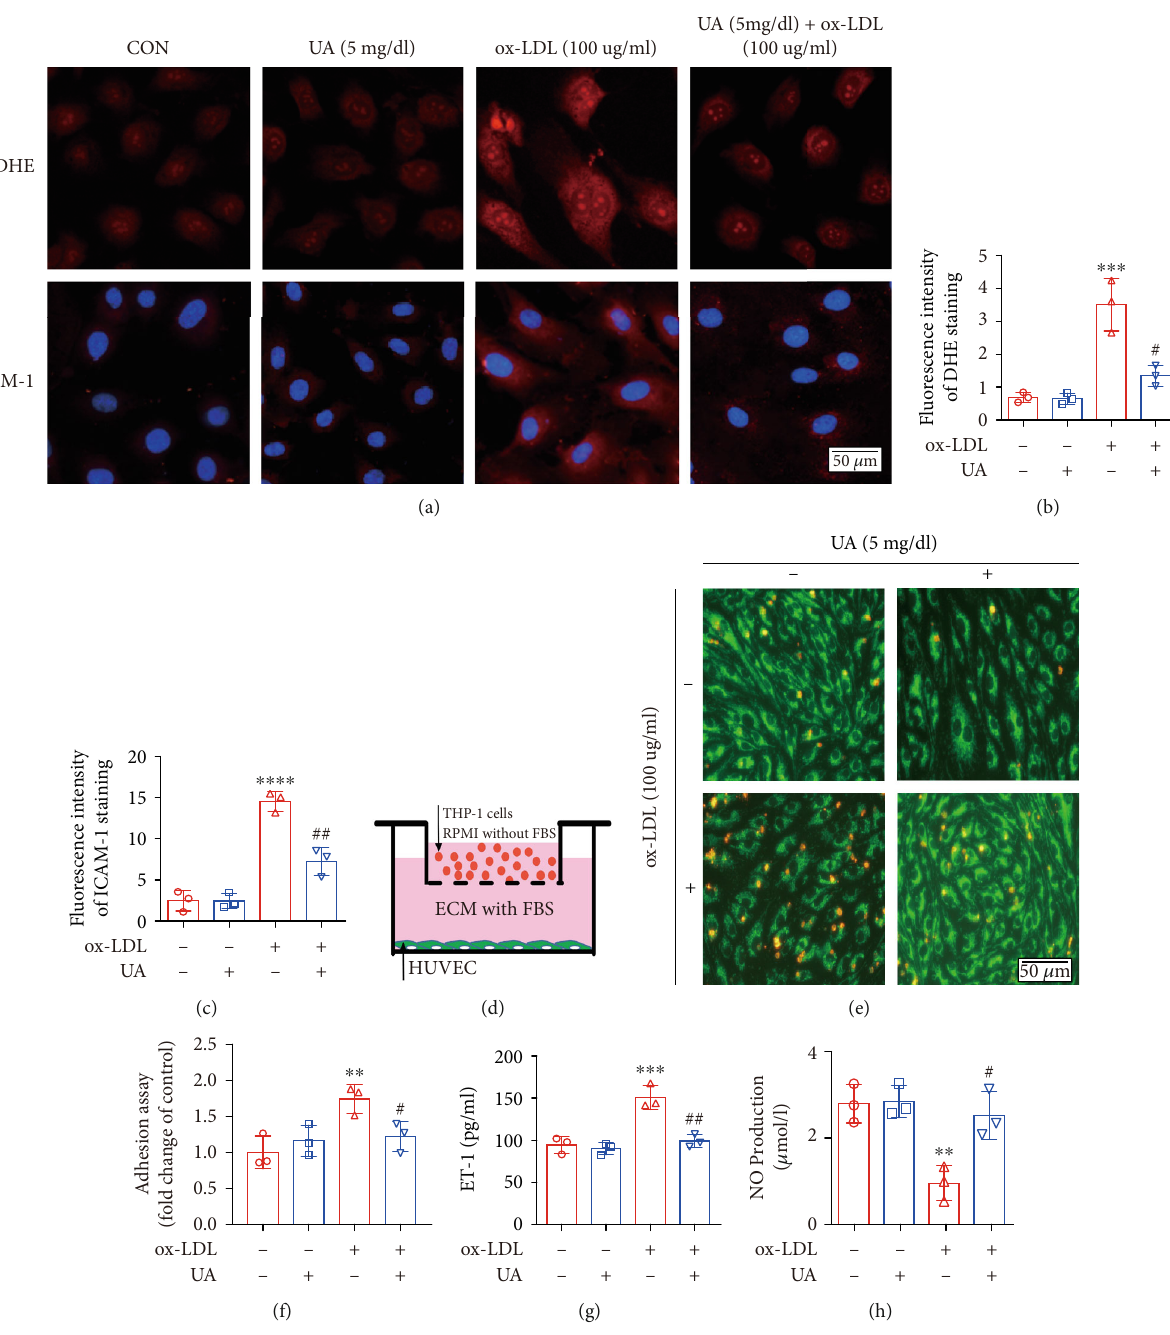
Figure 4: Appropriate concentration uric acid attenuated ox-LDL-induced injured in HUVECs. HUVECs were incubated with ox-LDL (100 μ g/mL) for 24 h, with or without uric acid (5 mg/dL) preincubated for 2 h. Or HUVECs were incubated with uric acid (5 mg/dL) alone for 24 h. (a) Representative immuno fl uorescence image of DHE and ICAM1. Scale bar = 50 μ m. (b) Densitometry analysis of immuno fl uorescent intensity of DHE in the HUVECs in di ff erent groups. (c) Densitometry analysis of immuno fl uorescent intensity of ICAM1 in the HUVECs in di ff erent groups. (d – f) Representative images showed adhesive monocytes to HUVECs under uric acid (5 mg/dL) treatment or ox-LDL (100ug/mL) treatment or uric acid (5 mg/dL)+ ox-LDL (100 μ g/mL). HUVECs were stained by Mito- Green, determined by green fl uorescence, while THP-1 cells were stained by Dil, determined by yellow fl uorescence. Quantitation of adhesive monocytes in di ff erent groups was presented in (f). (g) The e ff ect of uric acid and ox-LDL on ET-1 expression in HUVECs. ET- 1 released into the supernatant was measured by ELISA. (h) The e ff ect of uric acid and ox-LDL on NO production in HUVECs. The results were independently repeated at least three times. DHE: dihydroethidium; HUVECs: human umbilical vein endothelial cells. The statistical analyses were done using GraphPad Prism V-7.0 software. Data are expressed as the mean ± standard deviation ( n = 3 ). One- way ANOVA and unpaired t -test was used in statistical analyses ( n = 3 /group). ∗ P < 0 : 05 , ∗∗ P < 0 : 01 , ∗∗∗ P < 0 : 001 , and ∗∗∗∗ P < 0 : 0001 versus the control. # P < 0 : 05 , ## P < 0 : 01 , ### P < 0 : 001 , #### P < 0 : 0001 versus the ox-LDL